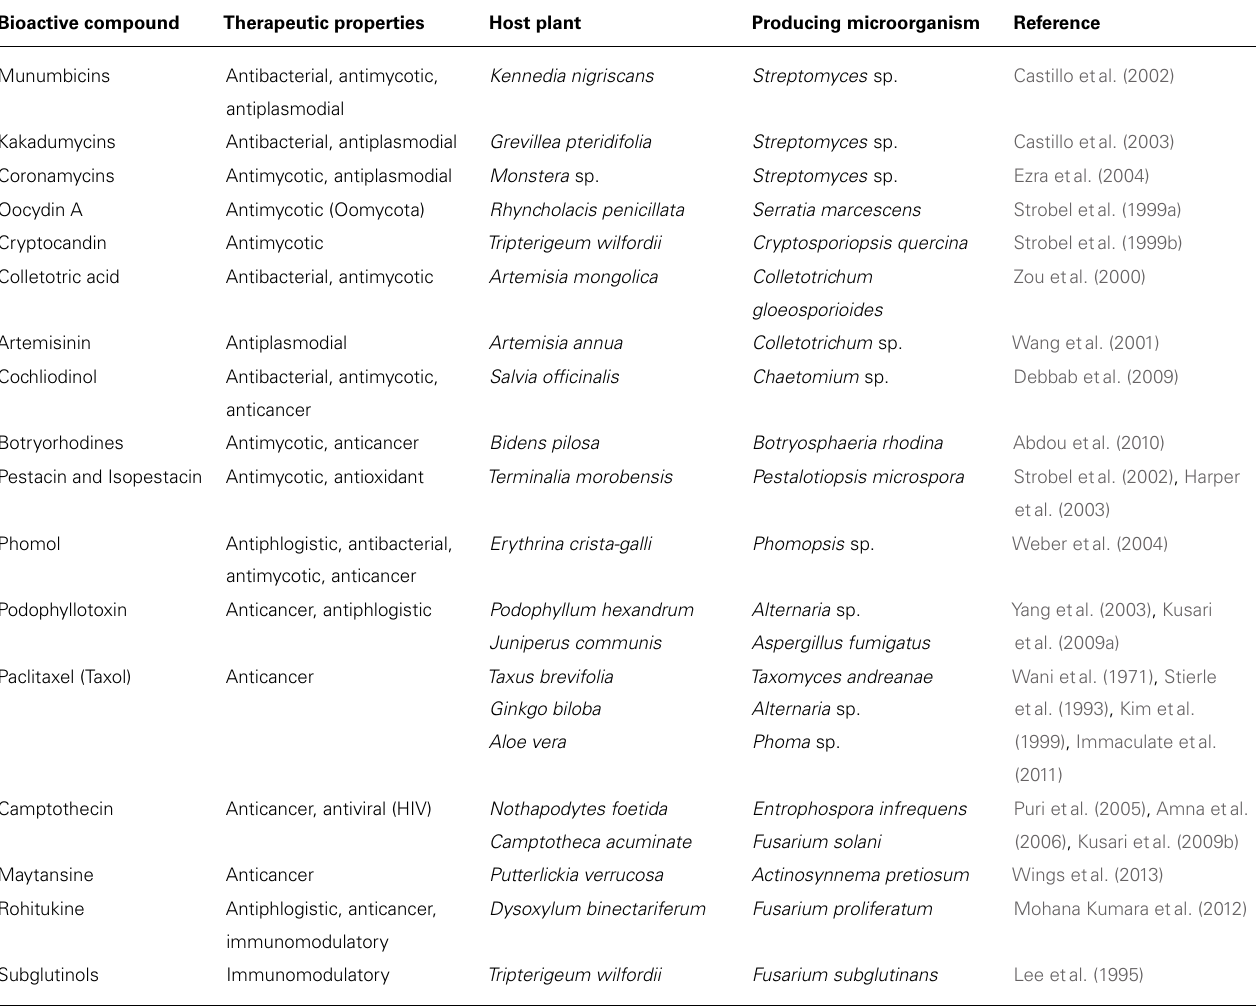
Table 1 | Examples for bioactive phytometabolites where microorganisms are involved in their